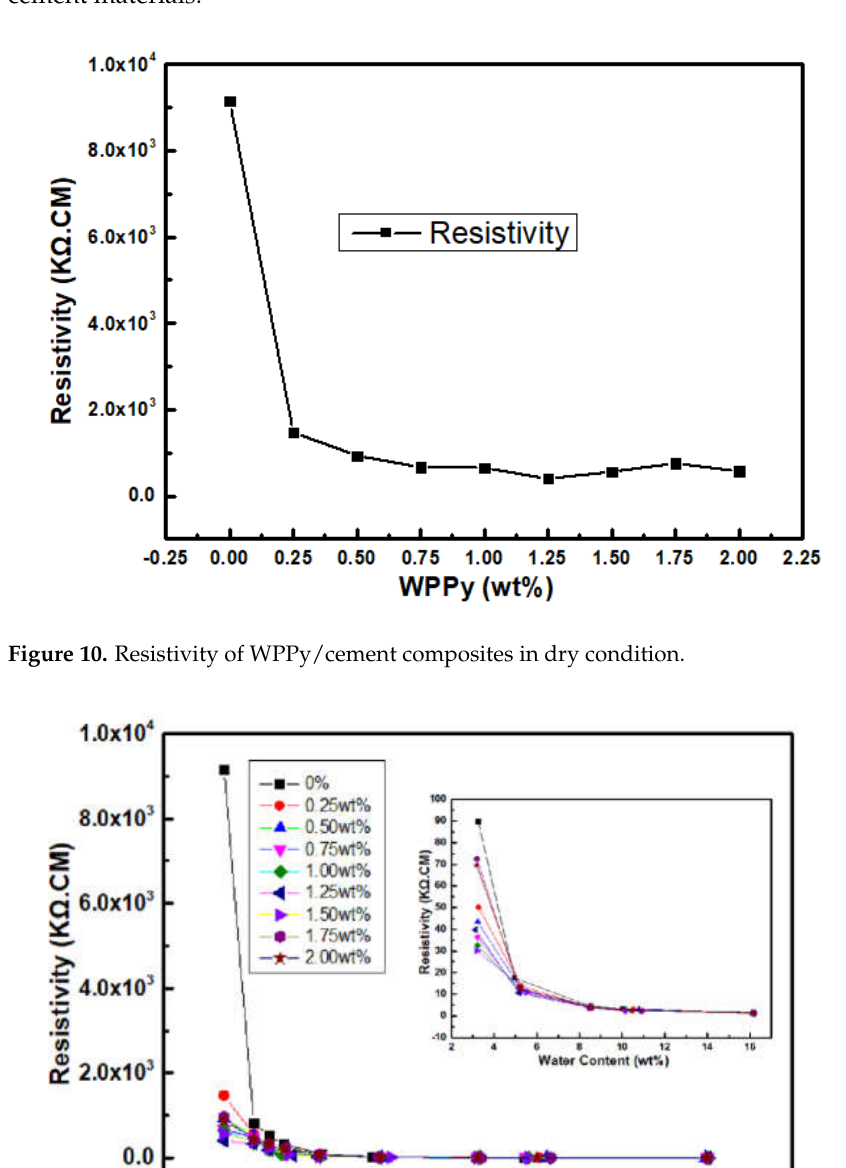
Figure 10. Resistivity of WPPy/cement composites in dry condition.